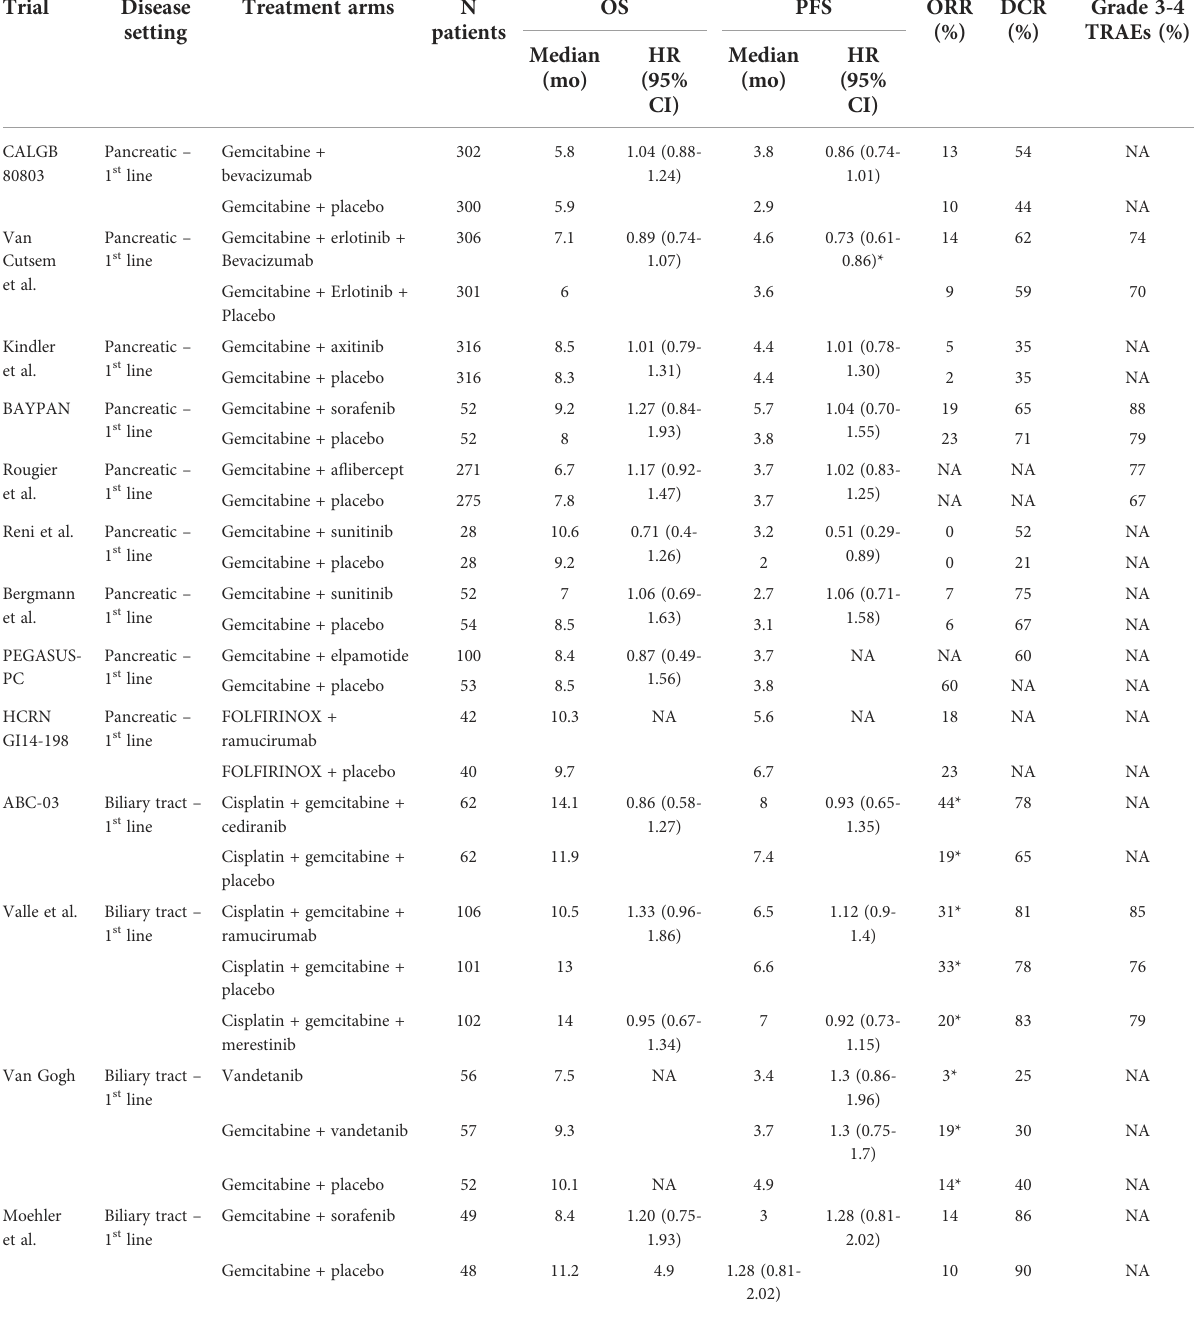
TABLE 4 Overview of selected phase II-III trials testing antiangiogenic agents in pancreatic and biliary tract cancer. Trial Disease